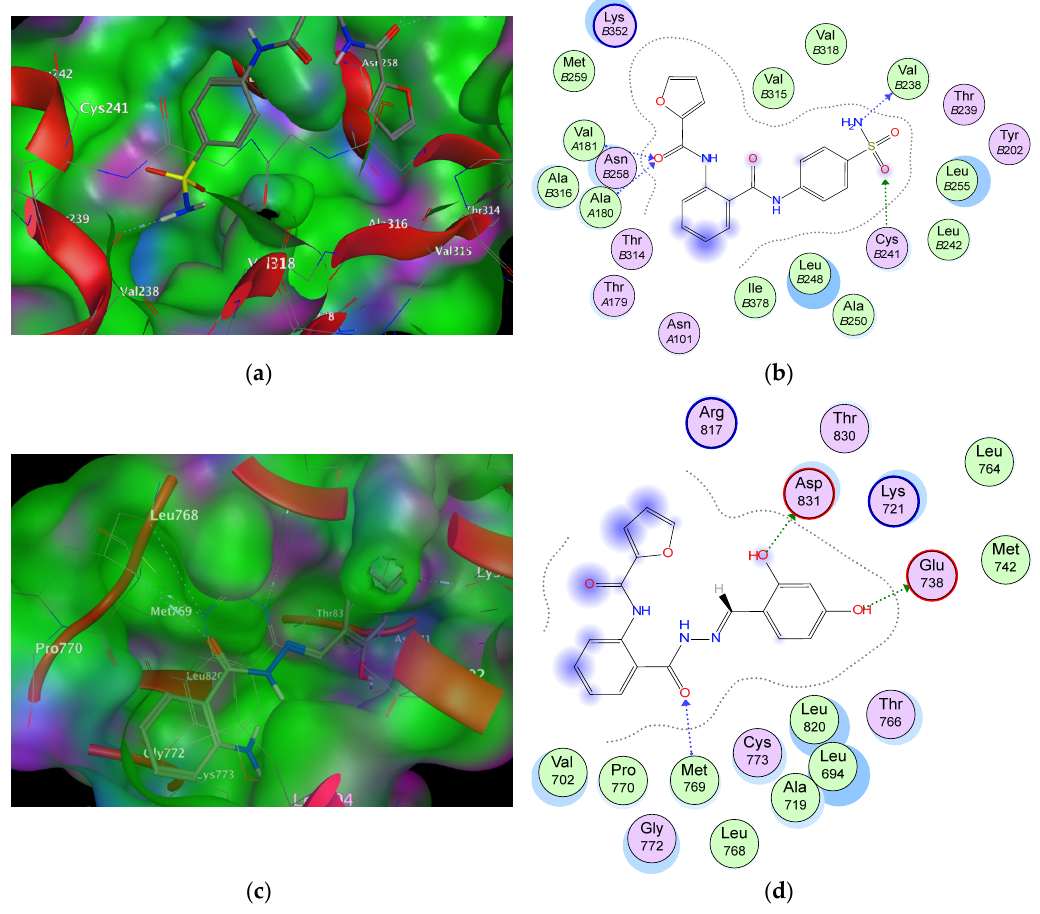
Figure 4. The top images ( a , b ) show 3D and 2D graphs of compound ( 9b ) docked into colchicine binding site of protein (1SA0). The bottom images ( c , d ) show 3D and 2D graphs of compound ( 6a ) docked into ATP binding site of protein (1M17). Green color indicates hydrophobic area, pink color indicates high polar area, blue color indicates mild polar area and dotted lines and arrows represent hydrogen bonds. Table 3. Description of the docking data of selected target compounds.